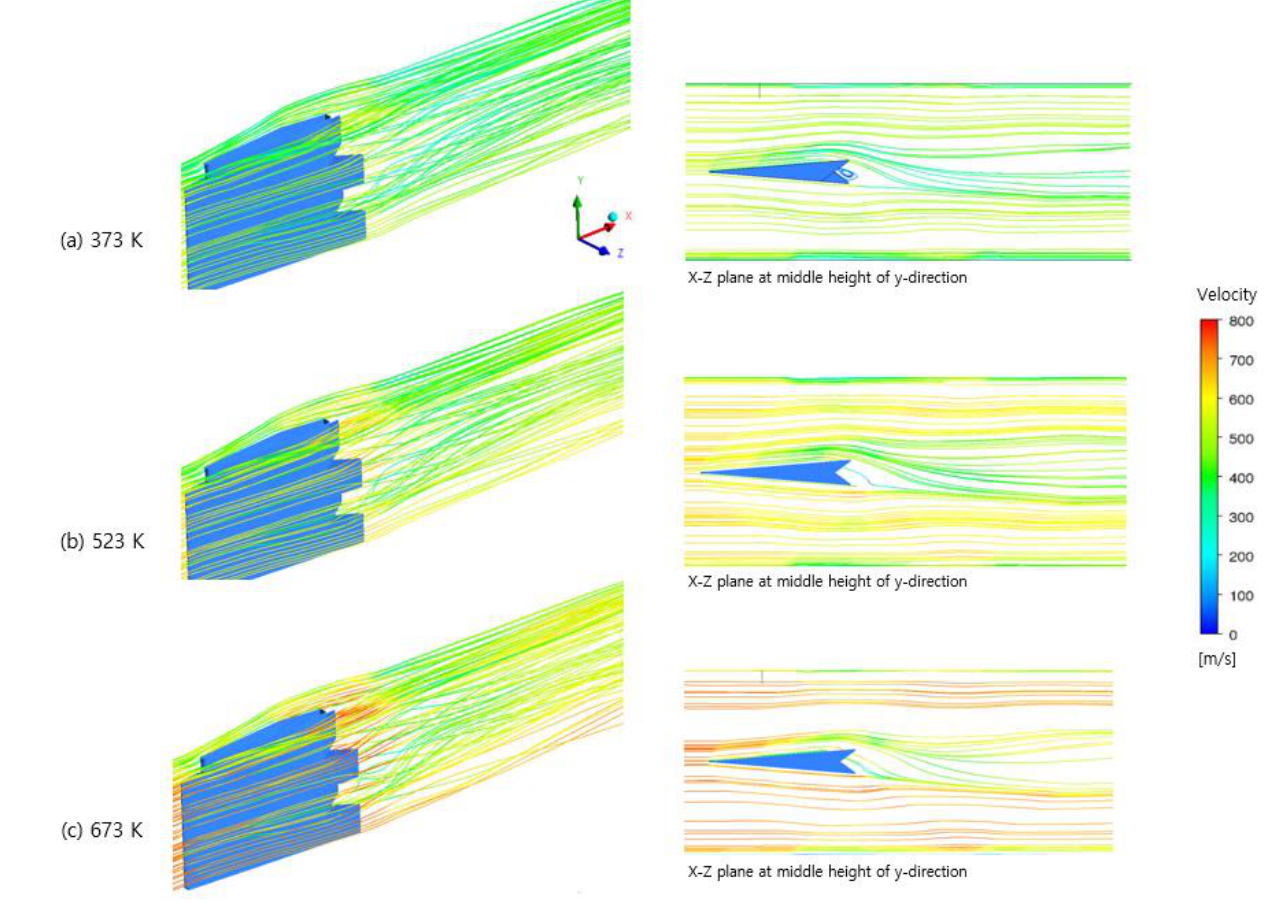
Figure 4. Streamlines and velocity contours near the pylon for three different air temperatures: 373 K, 523 K, and 673 K.